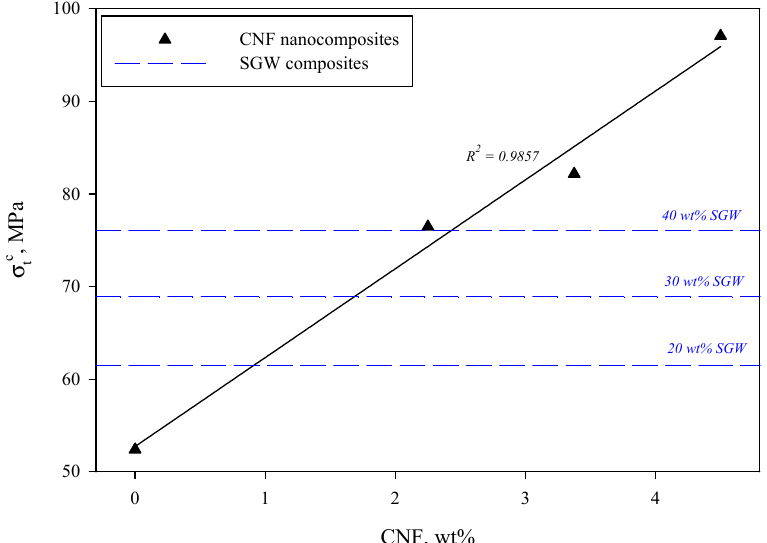
Figure 2. Evolution of tensile strength ( σ tc ) as the amount of CNF was increased. Blue dashed lines indicate the tensile strength of polyvinyl alcohol/stone groundwood (PVA/SGW) composites at different SGW content for comparison purposes.